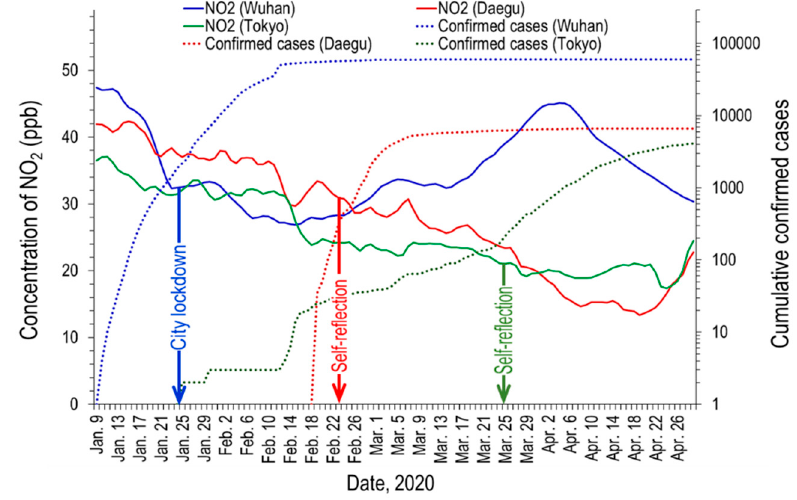
Figure 6. Daily variations of the concentration of NO 2 in Wuhan, Daegu, and Tokyo, with cumulative confirmed cases of COVID-19.